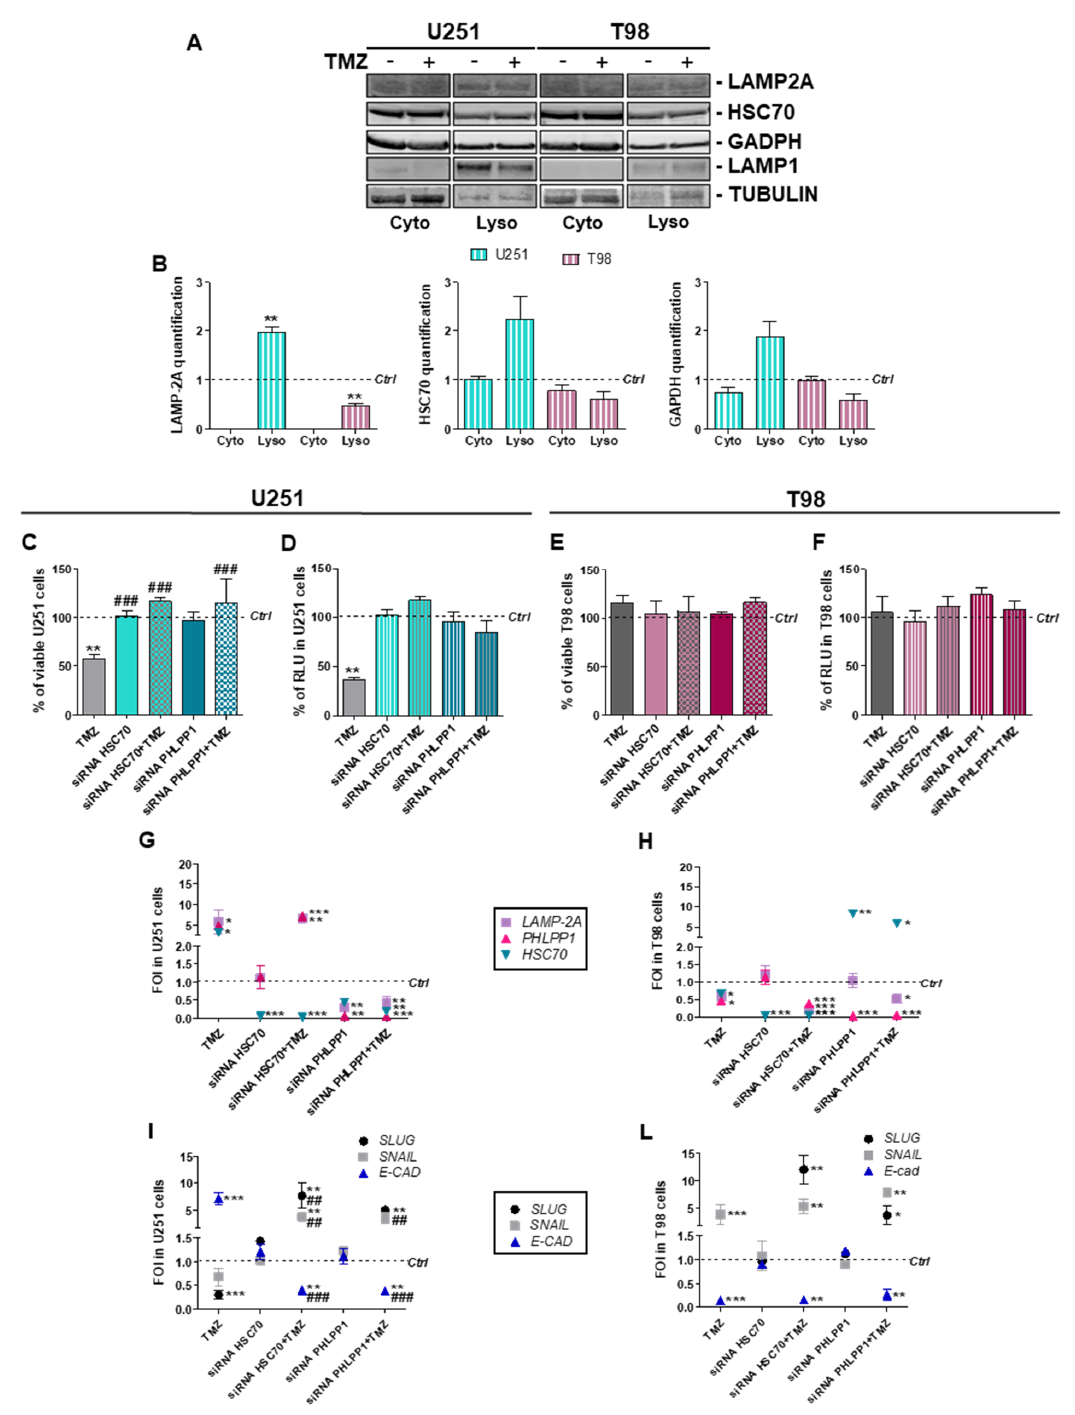
Figure 3. Essential chaperone-mediated-autophagy related gene involvement in Temozolomide response in U251 and T98 cells. ( A ) Western blot analysis of LAMP2A, HSC70 and GAPDH protein levels in subcellular fractions (Cyto = cytosolic fraction; Lyso = Lysosomal fraction) obtained from untreated (−) and Temozolomide (TMZ) treated (+) U251 and T98 cell lines. ( B ) Protein signals were